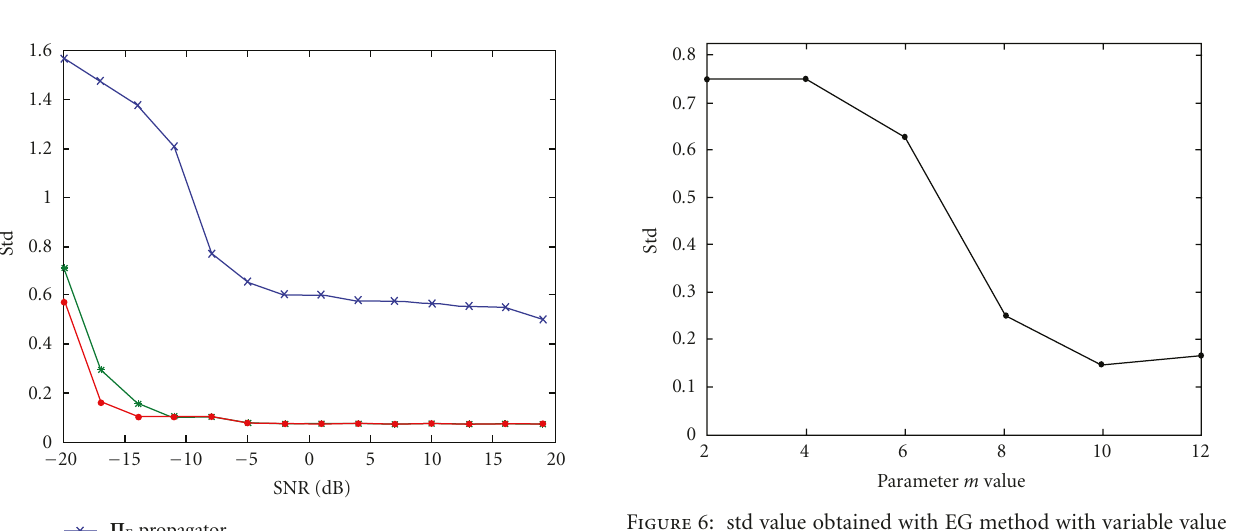
Figure 6: std value obtained with EG method with variable value of parameter m and P =